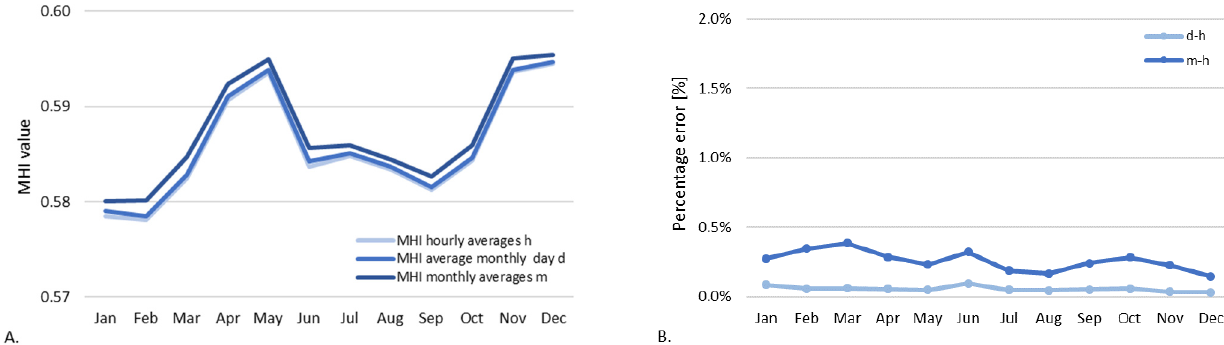
Figure 9. Singapore MHI values ( A ) and percentage error ( B